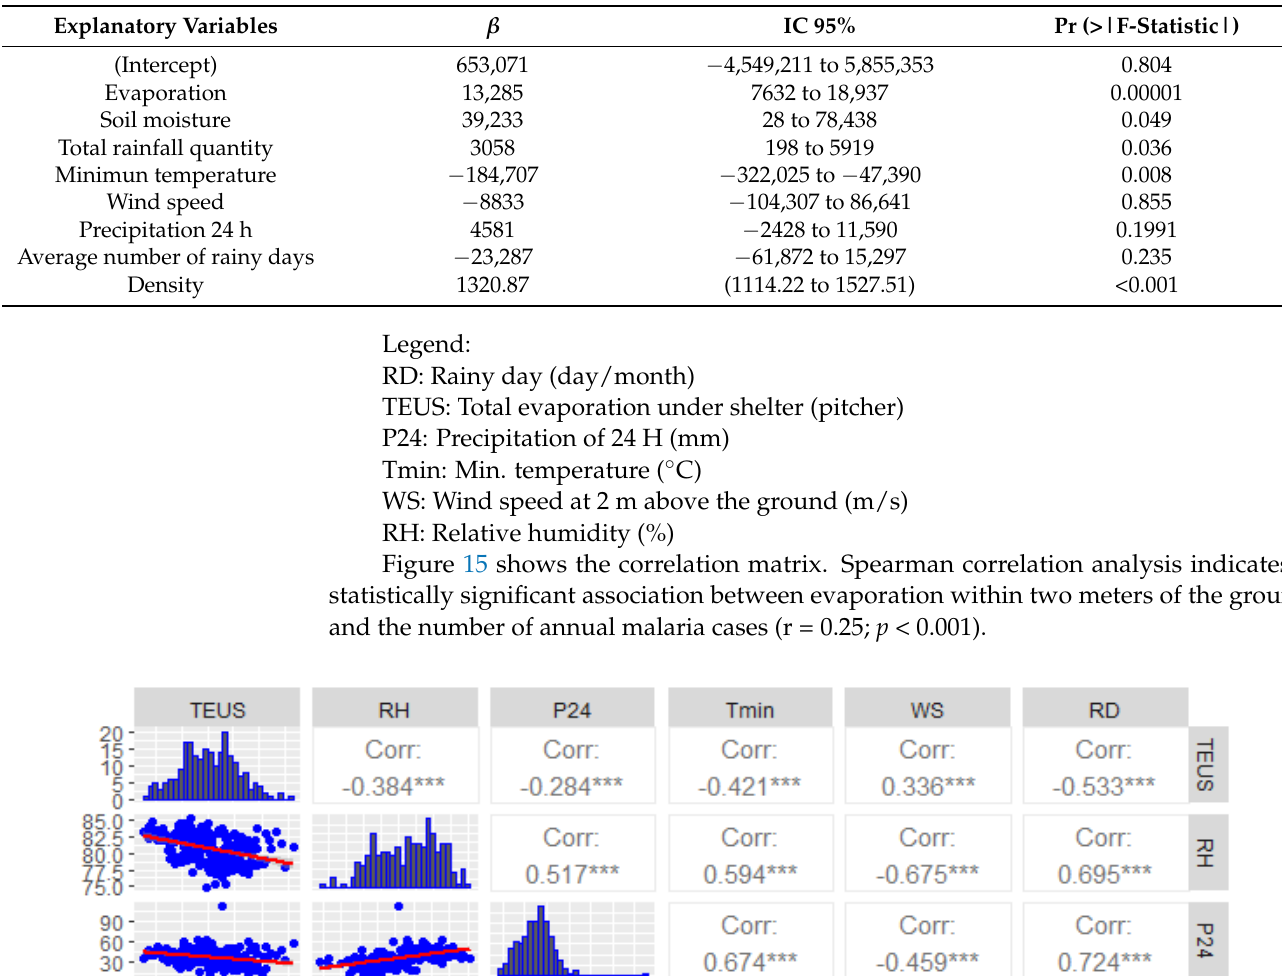
Table 6. Multivariate time series analysis of Geoclimatic factors and Malaria Morbidity.